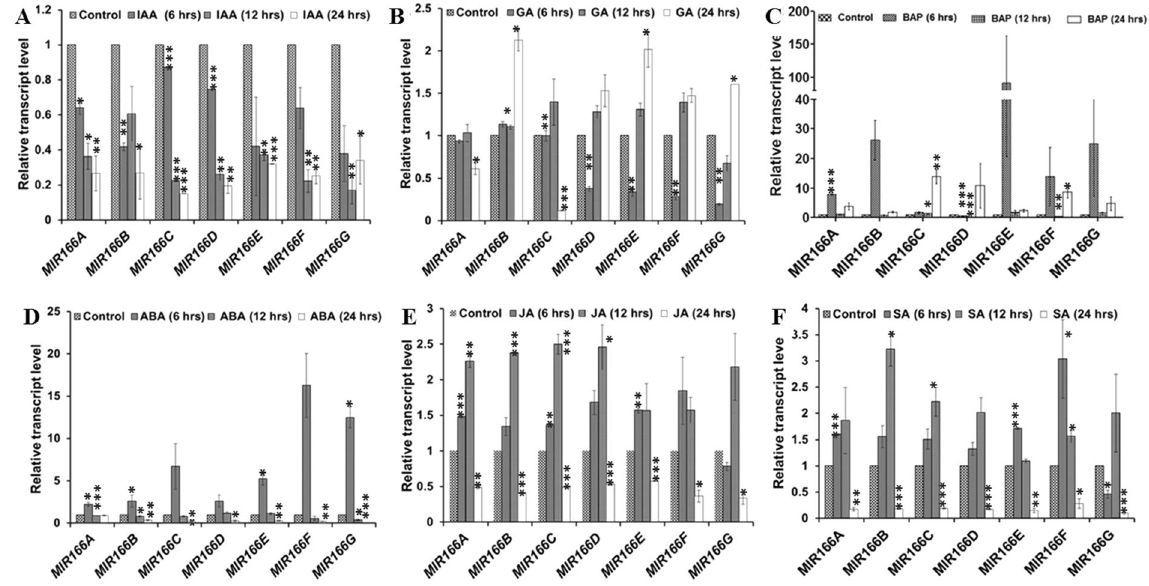
Figure 2. Phytohormones affect the expression level of precursor genes of MIR166 . The expression level of seven MIR166(A – G) genes was quantified using qRT-PCR in roots at 1, 6, 12, and 24 hrs with hormone concentrations of ( A ) 10 µ M IAA, ( B ) 10 µ M GA, ( C ) 10 µ M BAP, ( D ) 10 µ M ABA, ( E ) 20 µ M JA and ( F ) 100 µ M SA. The control indicates without treatment in each case. Error bars indicate ± SE of two independent biological experiments. One-way ANOVA was performed. Statistically significant differences are indicated as, * for P < 0.05, ** for P < 0.01 and *** for P < Mutants defective in hormone signaling show altered expression of miR166/165. in hormone insensitive mutants. Stem-loop qRT-PCR results showed that the exogenous IAA treatment led to the downregulation of miR166/165 expression level. To further confirm our result, we checked the expression of miR166/165 in seedlings of IAA insensitive auxin resistant2-1 ( axr2-1 ) mutant, which is defective in auxin perception and root development 25 . Interestingly, we observed that axr2-1 mutant root had significantly reduced level of miR166/165 expression (Fig. 3A). The reduced expression of miR166/165 in axr2-1 could be the result of increased endogenous auxin in axr2-1 , as observed in case of shy2-2 26 . Stem-loop qRT-PCR results showed that the exogenous GA treatment led to the upregulation of miR166/165 level. To further confirm our result, we checked the expression of miR166/165 in roots of GA insensitive pentuple mutant of all five DELLA proteins, gai-t6 rga-t2 rgl1-1rgl2-1rgl3-1 using stem-loop qRT-PCR analysis. When we checked the expression of miR166/165 in DELLA pentuple mutant, we found increased expression level of miR166/165, similar to the exogenous GA treatment (Fig. 3B). The exogenous ABA application inhibited primary root growth (Supplemental Fig. S1C). We observed signif- deficient 27 . Roots of aba1-1 mutant showed reduced expression level of miR166/165 in comparison to wild type arr1-3 arr12-1 double mutant, which shows CK insensitivity towards root elongation, LR formation and callus induction 28 . Since exogenous CK inhibits primary root elongation, arr1 arr12 mutant shows longer root phe- notype suggesting CK insensitivity 29 . In our experiment, exogenous BAP treatment induced the expression of miR166/165. In comparison to wild type, the expression of miR166/165 was reduced in arr1 arr12 mutant, which further confirmed the CK mediated regulation of miR166/165 (Fig. 3D). The exogenous JA treatment caused reduction in primary root length (Supplemental Fig. S1D). We observed that JA treatment induced the expression of miR166/165 significantly. To genetically confirm this, we checked the expression of miR166/165 in seedlings of coi1-16 ein2-1 pen2-4 triple mutant, which is JA insensitive 30 . Triple mutant roots showed reduced expression of miR166/165 in comparison to wild type (Fig. 3E). Exogenous SA application showed inhibitory effect on primary root length (Fig. 3F). Exogenous application of SA induced the transcript level of miR166/165 in roots. To genetically confirm this, we checked its expression in npr1-2 mutant, which is insensitive to SA treatment. The endogenous SA level in npr1-2 mutant was less in comparison to wild type root 31 . Roots of npr1-2 show reduced expression level of miR166/165 in comparison to wild type, which further confirmed SA mediated upregulation of miR166/165 in Arabidopsis roots. Over expression of miR166 ( miR166-Oe ) alters the sensitivity of roots to hormones.